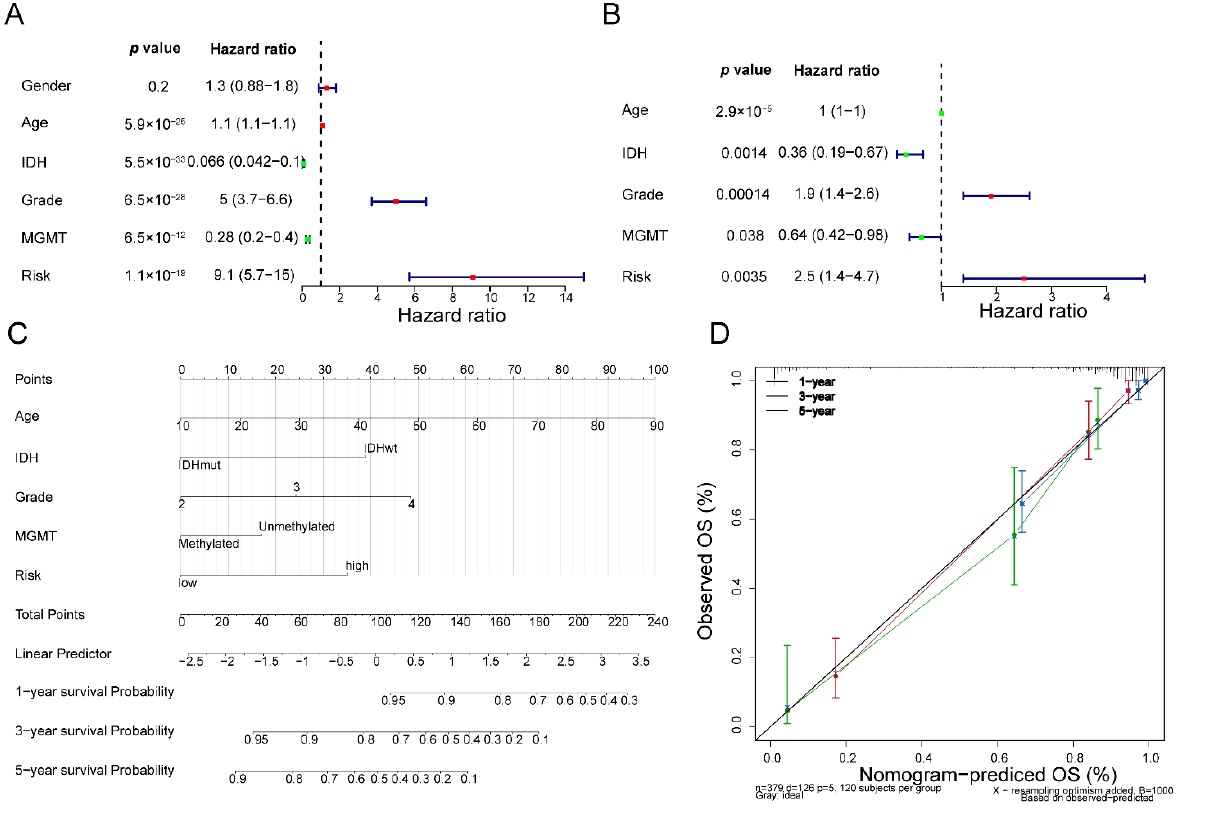
Figure 4. The fibroblast-related nomogram model: ( A ) forest map of univariate Cox regression analysis; ( B ) forest map of multivariate Cox regression analysis; ( C ) nomogram for predicting survival with independent prognostic factors; and ( D ) calibration curve for nomogram.